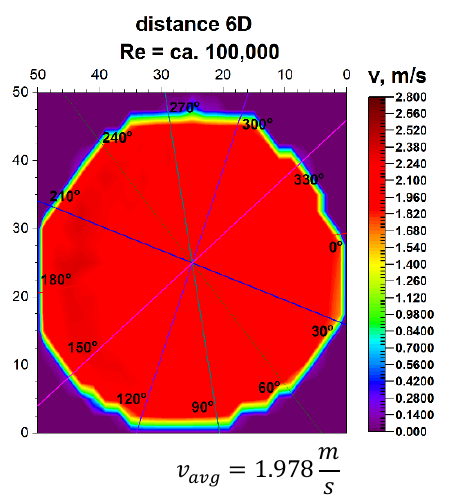
Figure 14. Projection on the velocity block at the distance 6D from the disturbance with marked cross-sections for Re ≅ 100,000.